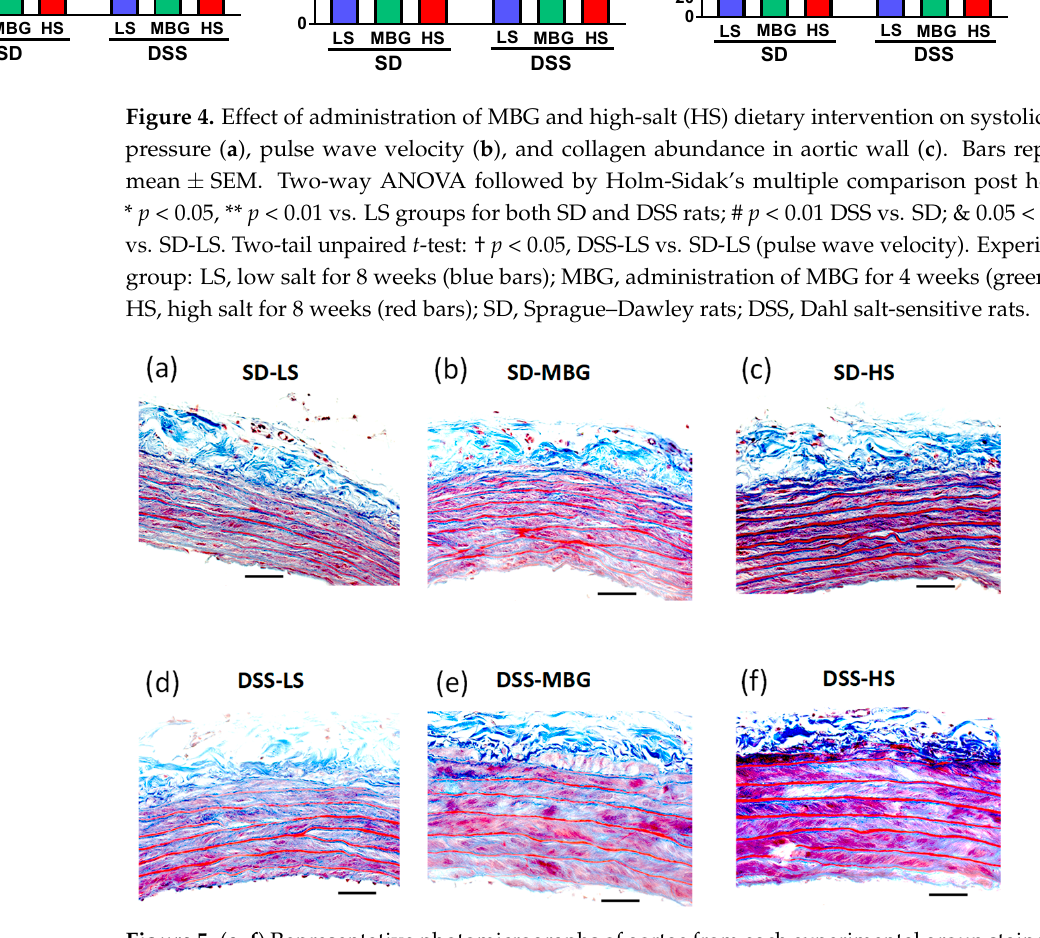
Figure 5. ( a – f ) Representative photomicrographs of aortae from each experimental group stained with Masson’s trichrome stain. Collagen in the aortic wall is stained blue; muscle and intracellular